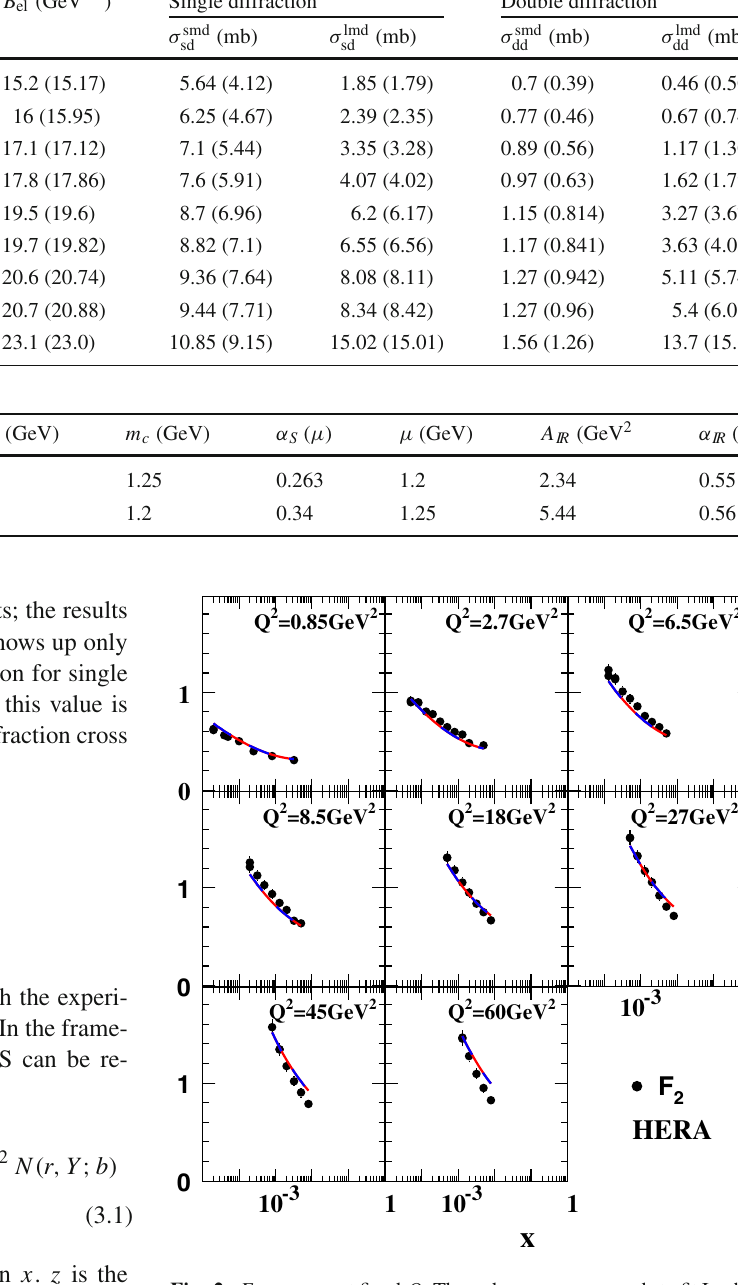
γ ∗ ( Q , r , z ) | 2 is the probability to find a In Eq. (3.1) | (cid:11) T , L dipole of size r in a photon with the virtuality Q , and with transverse or longitudinal polarization. The wave functions are known (see Ref. [49] and the references therein) and they are equal to the following